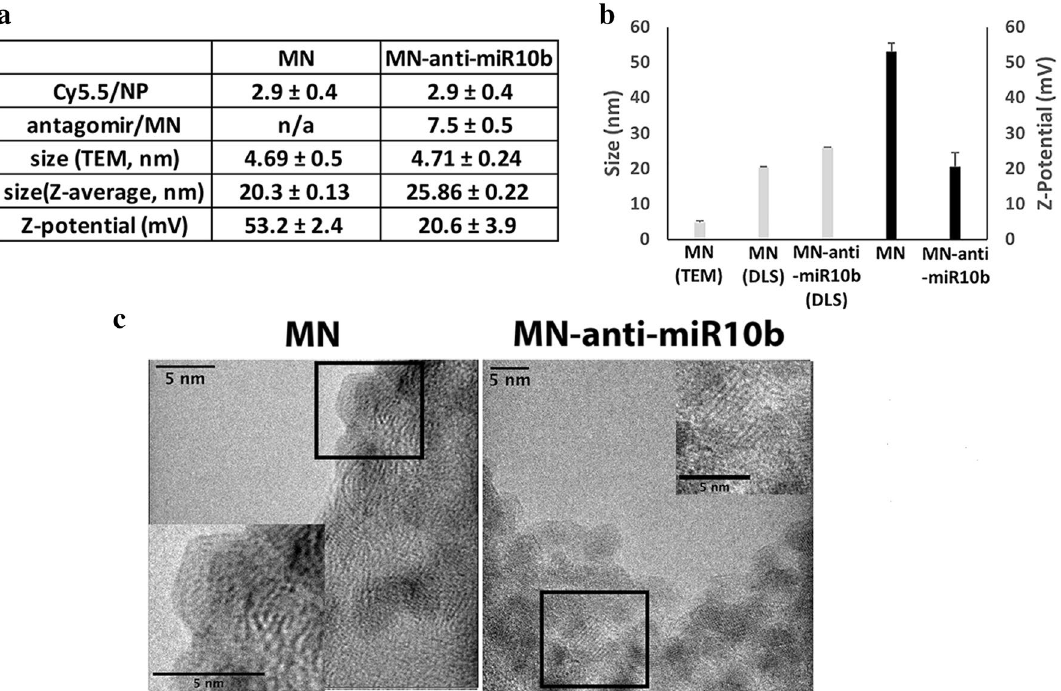
Figure 1. Synthesis and characterization of MN-anti-miR10b. ( a ) Characterization of the nanotherapeutic, which consisted of aminated dextran-coated iron oxide nanoparticles covalently conjugated to the Cy5.5 fluorescent dye and antagomirs against miR-10b. ( b ) Dynamic light scattering (DLS) to measure hydrodynamic diameter and zeta potential. The hydrodynamic diameter of MN-anti-miR10b was larger than that of the MN precursor. The zeta potential of MN-anti-miR10b was less positive than that of the oligo-deficient MN precursor (Unpaired t-test; n = 3; p ≤ 0.05). ( c ) Transmission electron microscopy (TEM) to measure iron core size